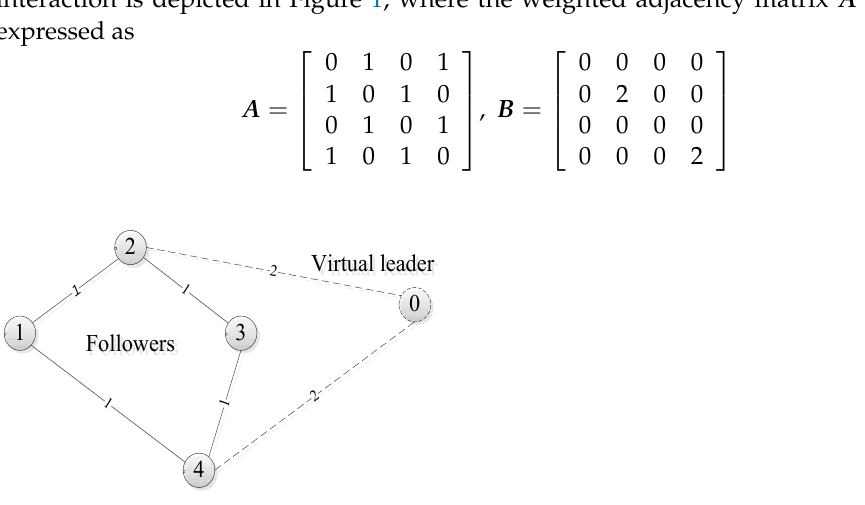
Figure 1. Communication topology of the augmented graph.